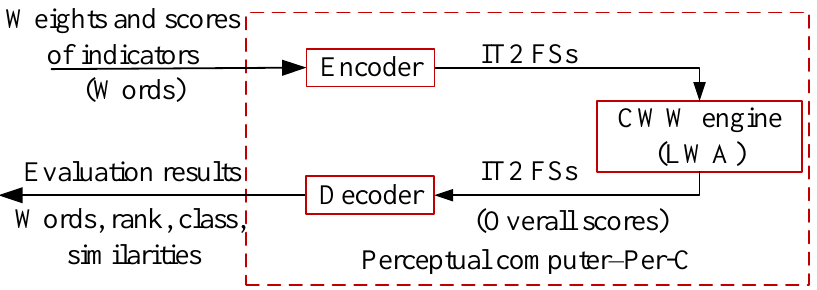
Figure 3. Conceptual structure of the proposed Per-C method based university teachers ’ teaching performance evaluation scheme.